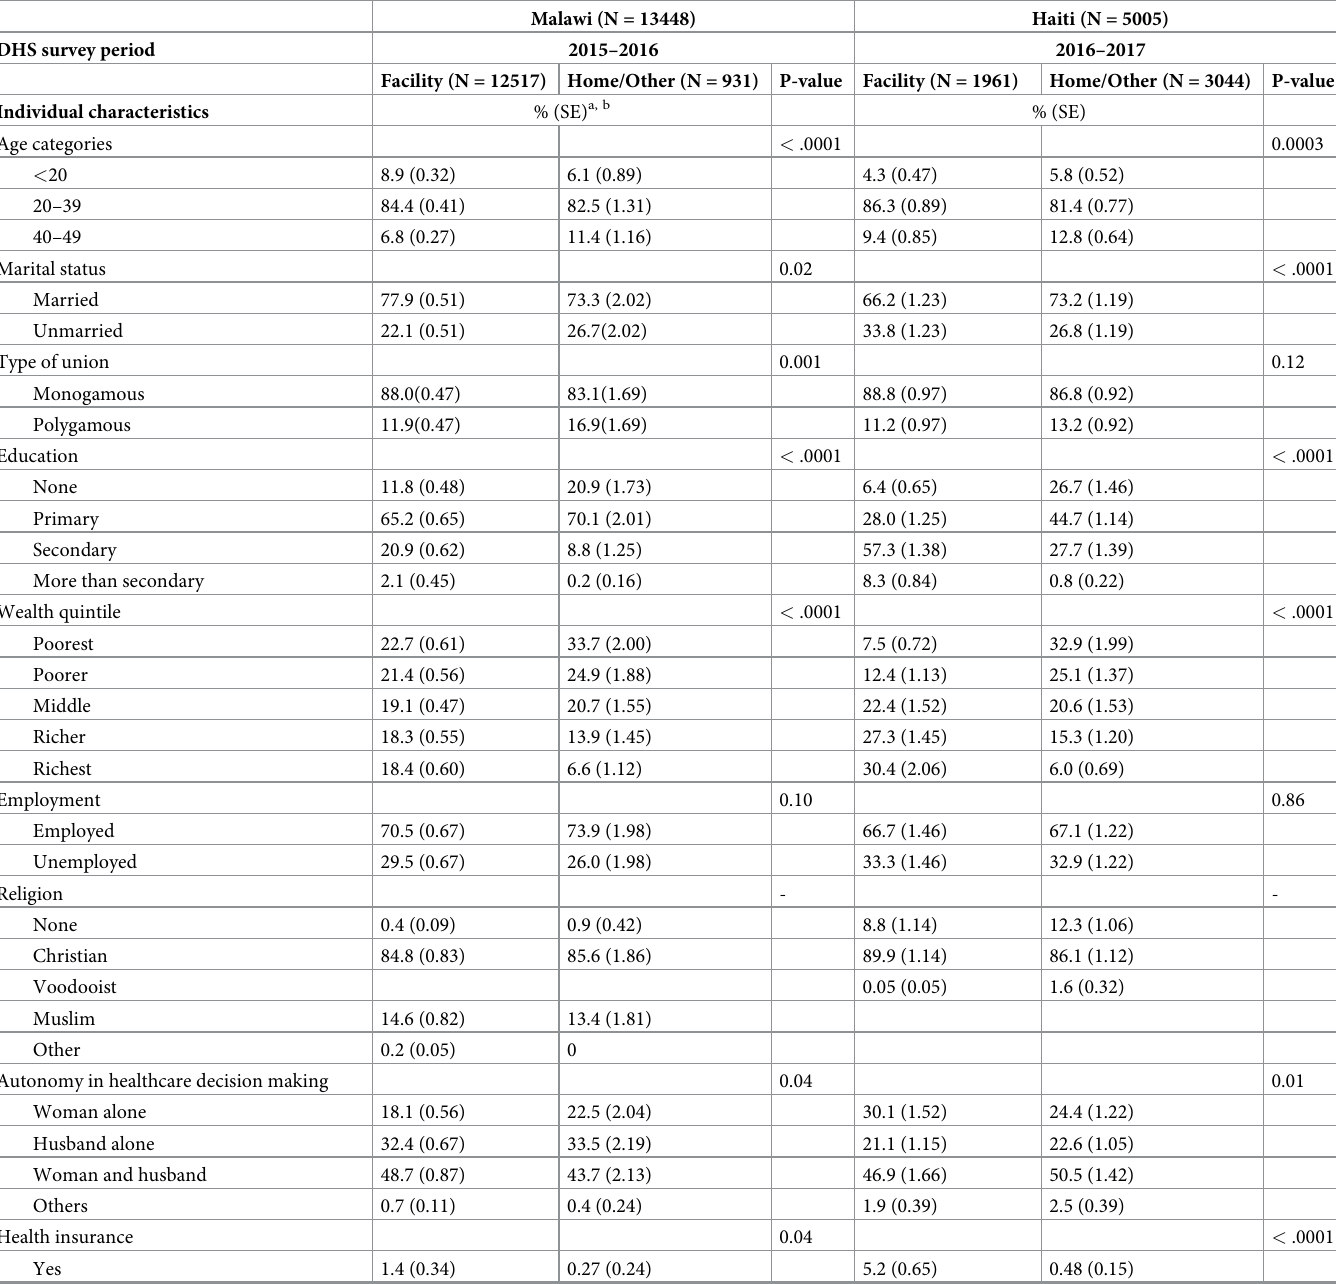
Table 1. Characteristics of women who had a childbirth in the last 5 years by place of delivery in Malawi and Haiti: Demographic Health Survey, 2015–2017. Malawi (N =